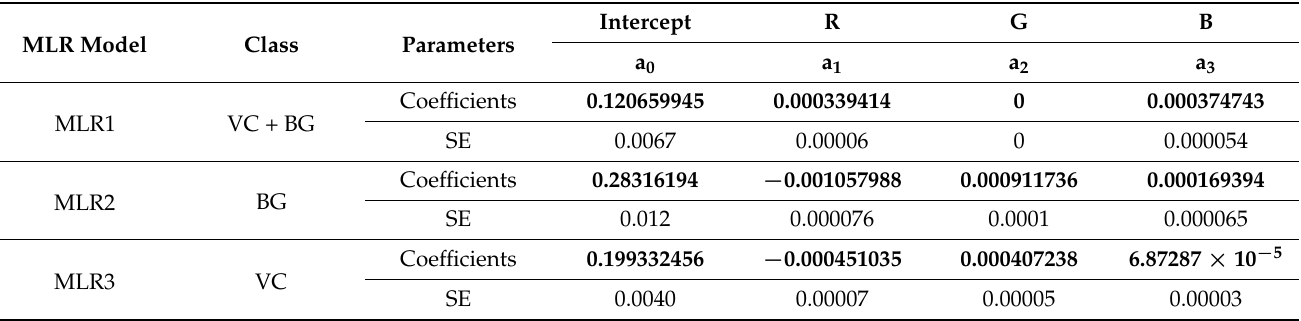
* Table Legend: Multiple Linear Regression (MLR), Standard Error (SE), Bare Ground (BG), Vegetation Covered (VC), Red (R), Green (G), and Blue (B). The sites and the ROIs with the RGB data used to build MLR models are tabulated in Table 8. After averaging, the multiclass RGB data vectors boil down to seven instances, with three belonging to the bare ground class and four to the vegetation covered class. The MLR1 model’s θ ’ predictions for the 370 RGB data vectors were grouped by their respective ROIs, and their averages were taken. MLR1 prediction results are presented in Table